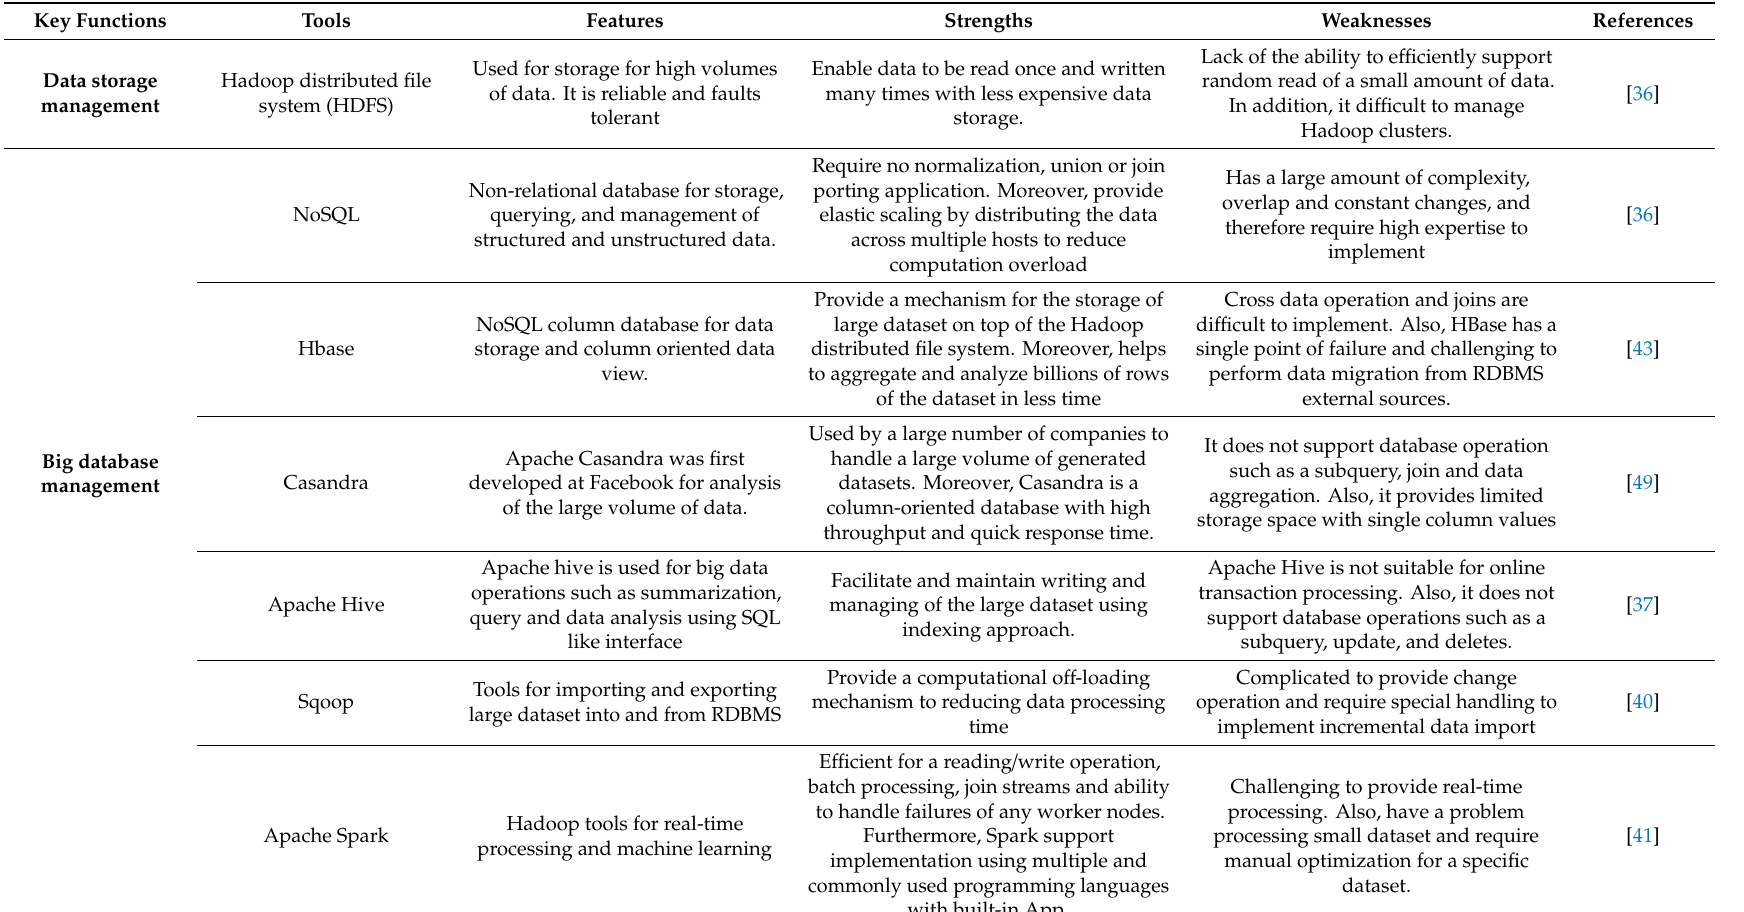
Table 2. Key features of big data analytics tools, strengths, and